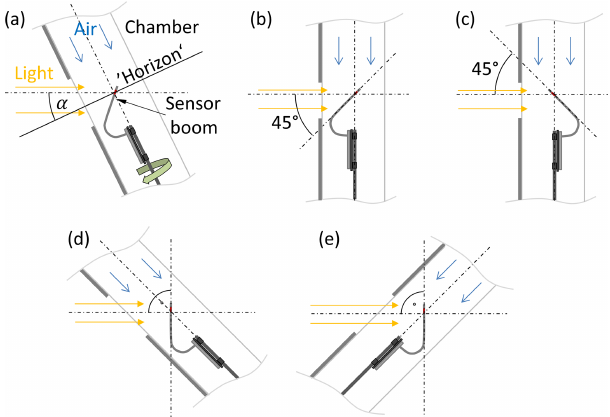
Figure 8. Settings for radiation incidence. (a) Configuration for measurements of the radiation error for incidence angles between 0 and 60 ◦ ; α is equivalent to the Sun elevation angle; sonde is con- tinuously rotating around longitudinal axis. (b, c) Simulation of in- cidence with the Sun at its zenith. (d, e) Simulation of incidence of diffuse radiation. In panels (b) to (e) the sonde is fixed (not rotat- ing).